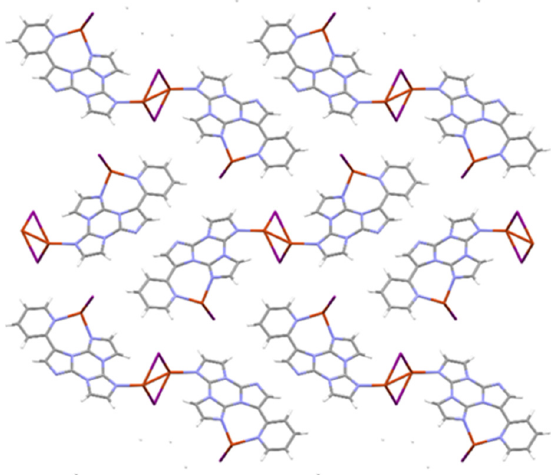
Figure 3. View down the crystallographic axis a showing the packing of the monodimensional chains of 1